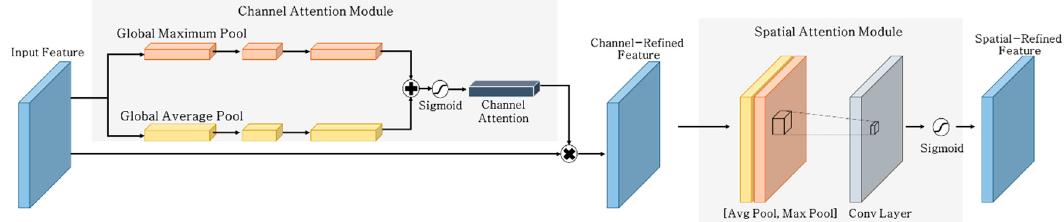
Figure 4. Attention network architecture.